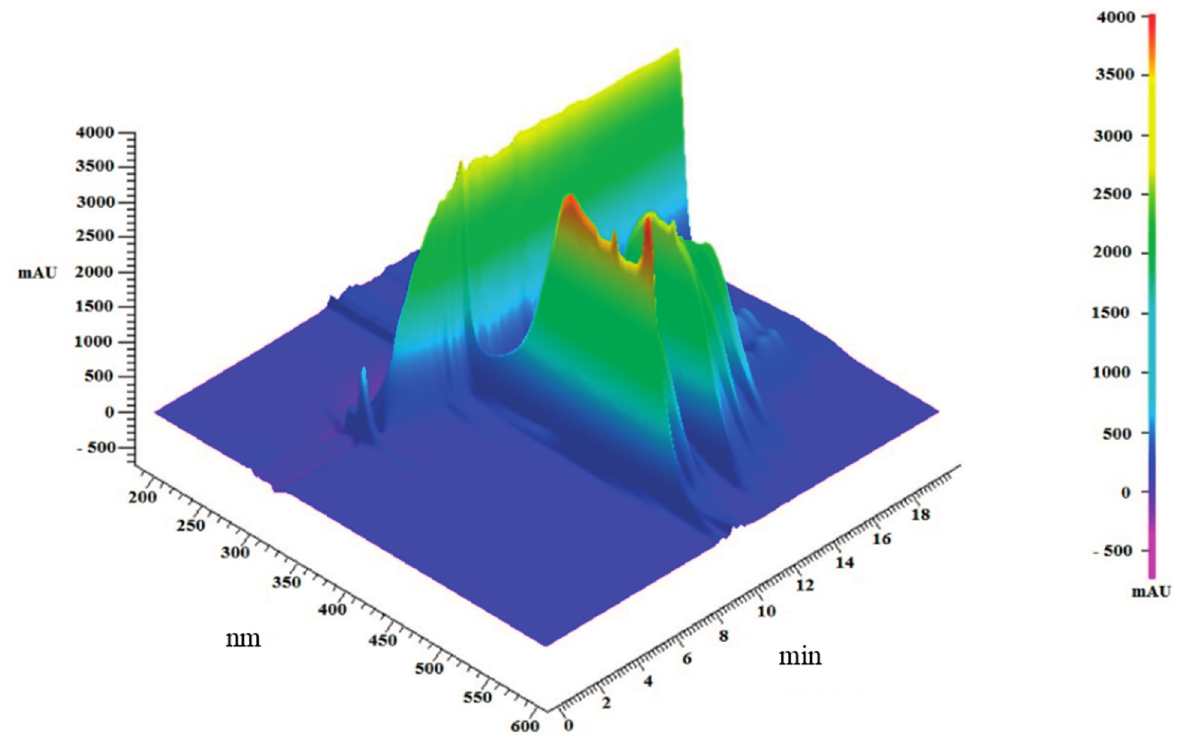
Figure 1. Spectrophotometric scanning of the lipidic extract from shrimp after reversed phase